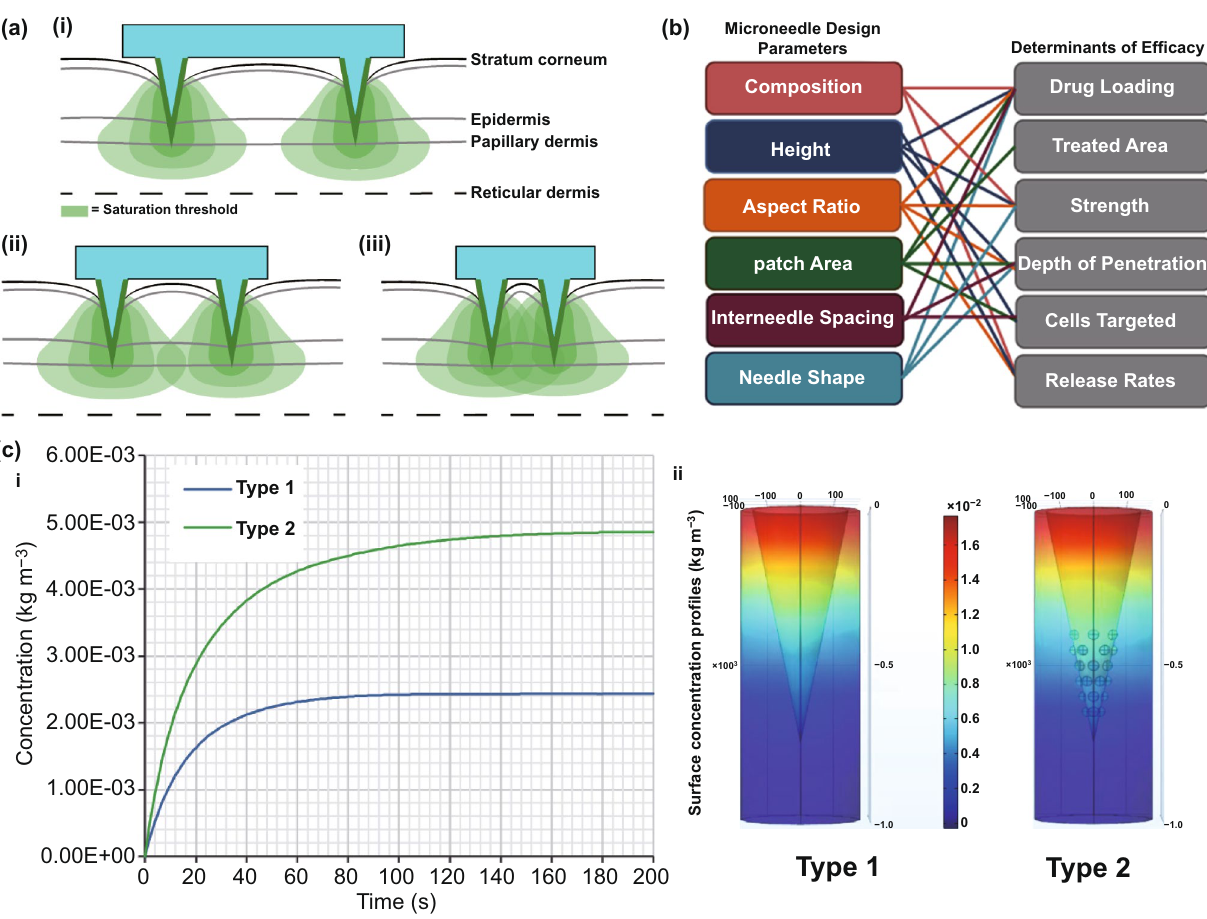
Fig. 11 a The number of cells activated by delivery of a dermal vaccine was dependent on MN spacing, as shown in the 2D drawings of a large (i), optimal (ii), and small (iii) distance between MNs. Reprinted from Ref. [145] with permission from Taylor and Francis. b Relationship between microneedle design parameters and therapeutic efficacy. Reprinted from Ref. [135] with permission from Plos One. c Time concentra- tion profile (i) of a standard conical dissolving MN shape (type 1) and a novel shape with hemispherical convexities to maximize drug delivery when partial needle insertion occurs (type 2) with surface concentration profiles (ii). Reprinted from Ref. [18] with permission from